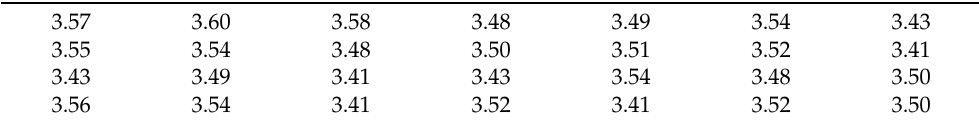
Table 2. 28 sample data of time length of in-control period.